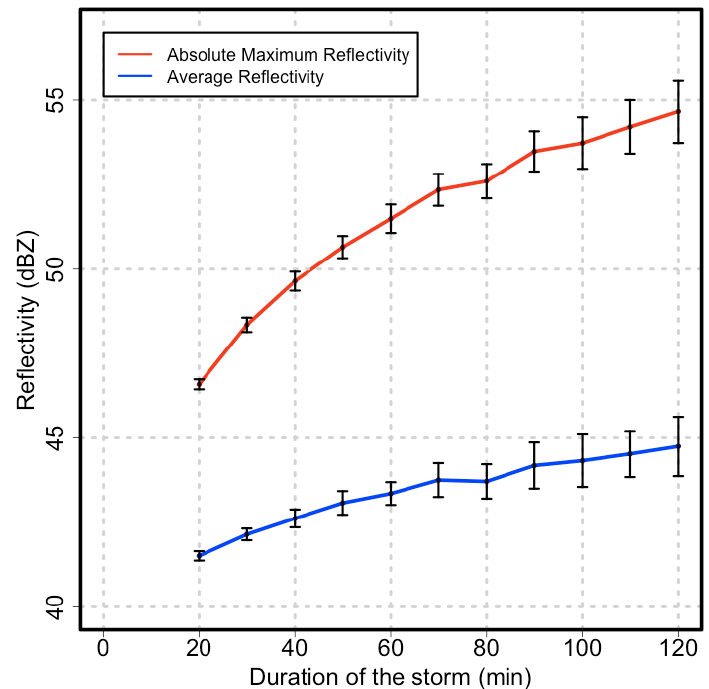
Figure 4. Absolute maximum values of reflectivity (red line) and mean reflectivity (blue line), averaged for different track duration. The error bars represent the standard deviation of the mean